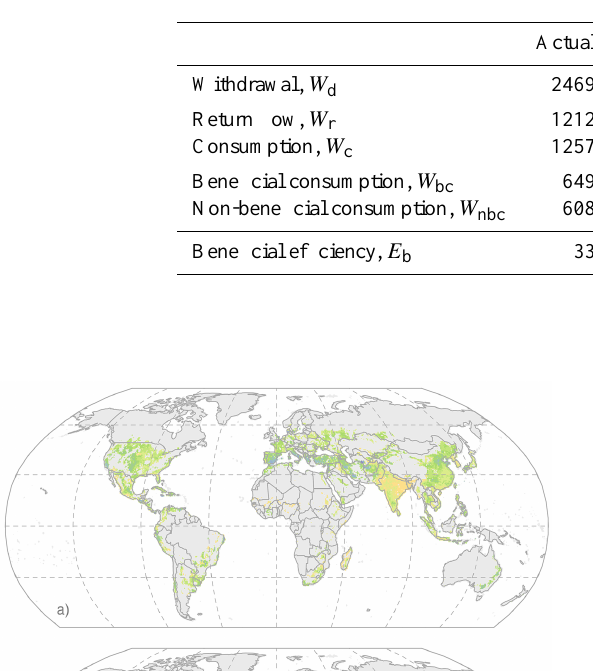
Table 3. Global annual sums (km 3 ) of irrigation water withdrawal ( W d ), return flow ( W r ), irrigation water consumption ( W c ) further split into beneficial ( W bc ) and non-beneficial consumption ( W nbc ), and global mean E b (average across irrigated cropland, in %), given as 2004–2009 averages. Values are for actual conditions and the all-surface, all-sprinkler, and all-drip scenarios.